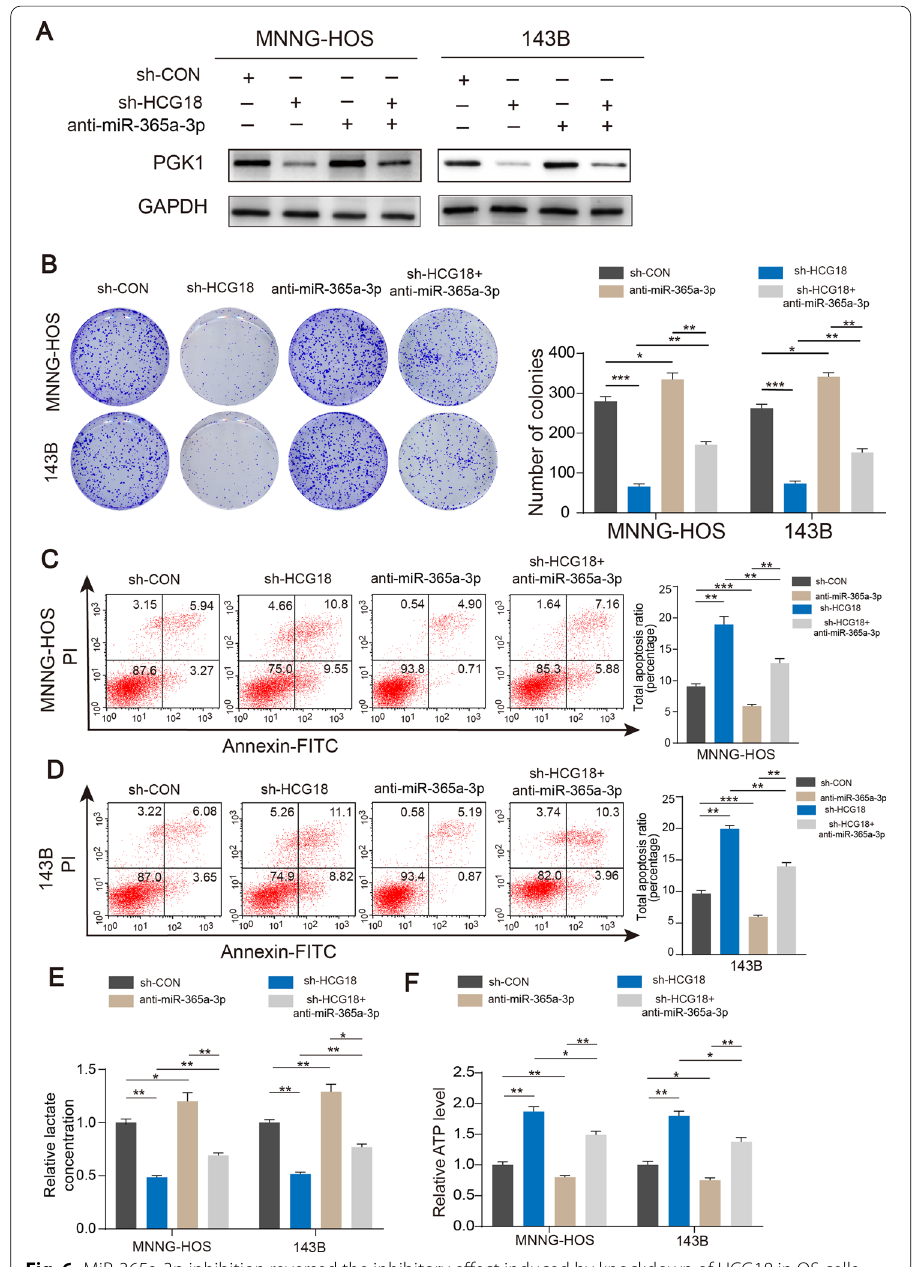
Fig. 6 MiR-365a-3p inhibition reversed the inhibitory effect induced by knockdown of HCG18 in OS cells. A Western blot showed the PGK1 expression of OS cells transfected with miR-365a-3p inhibitor, sh-HCG18, or negative control. Colony formation ( B ), and apoptosis ( C and D ) assays confirmed that knockdown of miR-365a-3p partly reversed the suppressive effects of HCG18 knockdown on OS proliferation. Knockdown of miR-365a-3p in wild-type OS cells (MNNG-HOS and 143B) also improved OS proliferation. E and F , Altered levels of lactate concentration and generative ATP in different groups (sh-Control, sh-HCG18, sh-HCG18 anti- miR-365a-3p and anti- miR-365a-3p) was measured. * represents P < 0.05, ** represents + P < 0.01, *** represents P < 0.001. All experiments were repeated three